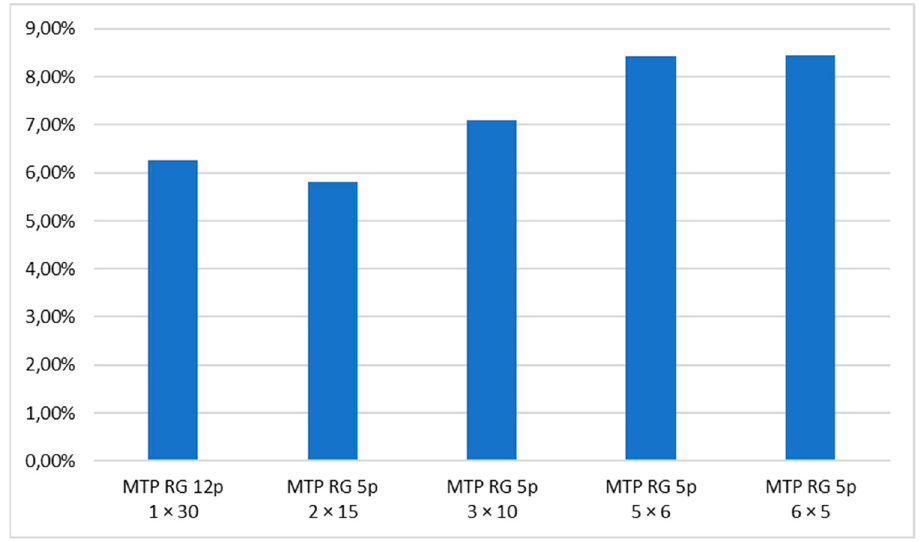
Figure 10. The average power savings per task for the architecture with a RAM-gating mechanism compared with the appropriate MTP structure.